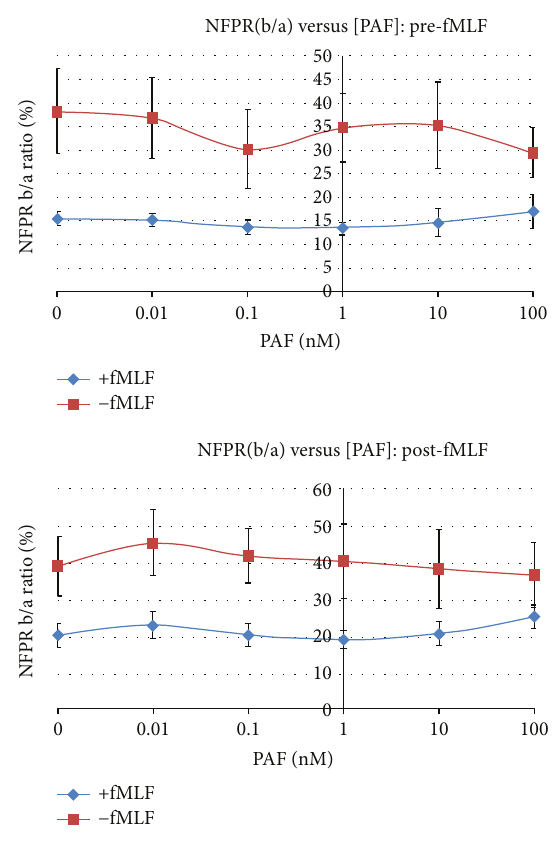
Figure 4: E ff ect of PAF exposure (pre-fMLF or post-fMLF) on relative FPR1 recognition by NFPR mAbs. Twenty-four wells of a 96-well microtiter plate were loaded with 5.0 × 10 5 PMN in twelve well sets. The cells were exposed to 50 μ L dilutions of PAF ranging from 0 to 100nM in RPMI and incubated at 37 ° C for 10min, followed by addition of 5 μ L of 5 μ M fMLF (+) or control RPMI bu ff er and then incubated for an additional 10min (upper graph labeled [PAF]:pre-fMLF). Alternatively, the order of additions was reversed except that incubation with PAF was for 5min ([PAF]: post-fMLF). The supernatants were then removed; the cells extracted with TL bu ff er at 4 ° C and processed as normally as described in the legend of Figure 3 and Materials and Methods. The 60K-FPR1 was then quantitated utilizing LI-COR Odyssey Image Studio software. The paired NFPRb/NFPRa integrated intensity ratios were calculated (see Supplement to Figure 4) and plotted as a function of the log of PAF concentration with the zero concentration plotted on the left ordinate. Error bars represent SEM for four measurements using cells from two blood donors. A representative immunoblot and Odyssey quantitation method are shown in Figure 4